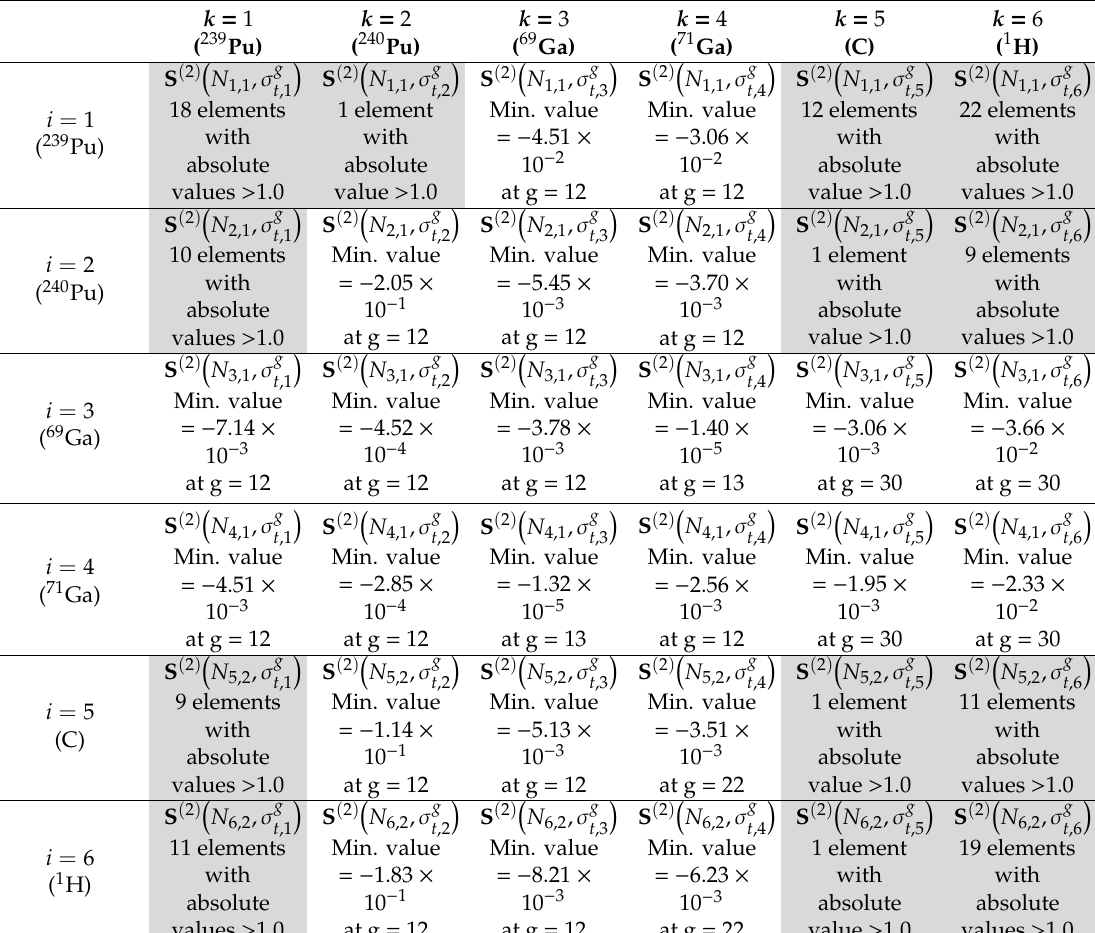
(cid:16) (cid:17) N i , m , σ g , i , k = 1, ... ,6; m = 1,2; g = 1, ... t , k